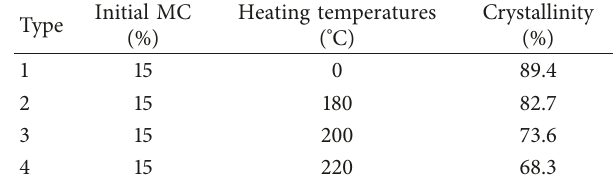
Table 5: Crystallinity of untreated and heat-treated specimens.